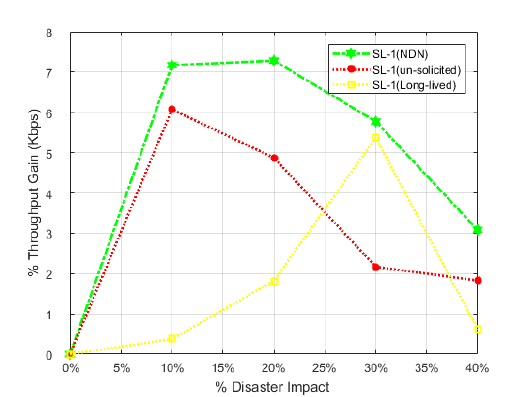
Figure 11. Throughput Gain w.r.t NDN-DISCA to Existing Schemes i.e., NDN, Un-solicited and Long-lived in SL-1.